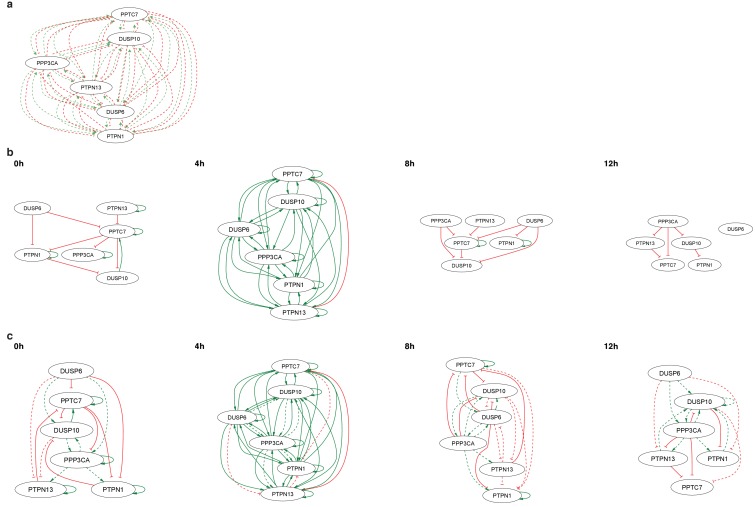
Simulated Boolean networks.(a) Single ABN with all possible interactions among the six commitment phosphatases. (b) RE:SIN representation of the same networks as in Figure 4a. (c) RE:SIN representation of the networks as in b) (solid lines) and additional possible interactions (dashed lines) inferred from Figure 4—figure supplement 2d,e.